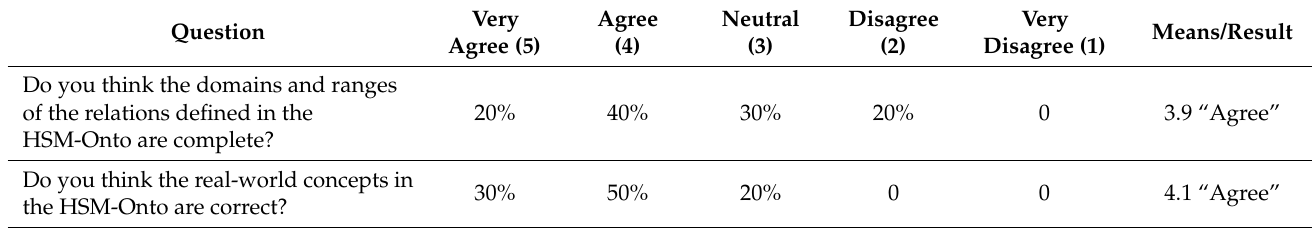
Table 3. Questionnaire made for the ontology semantic